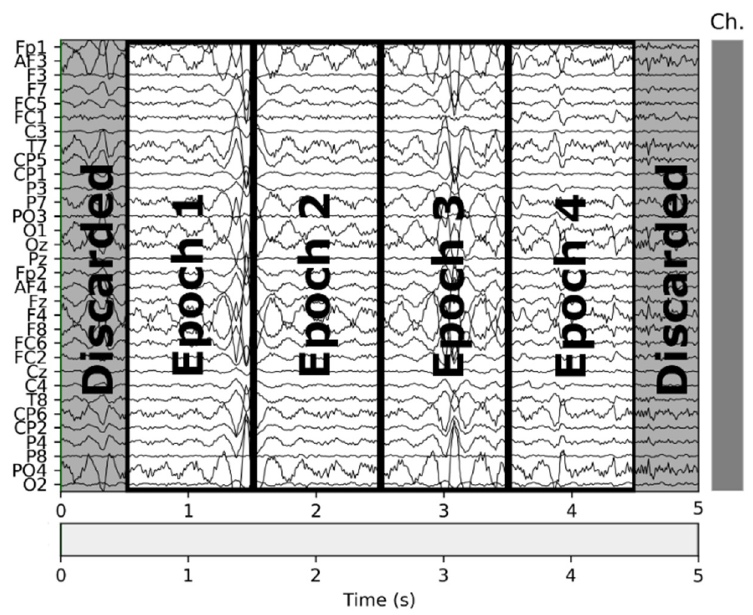
Figure 2. Epochs obtained from a 5-s segment.